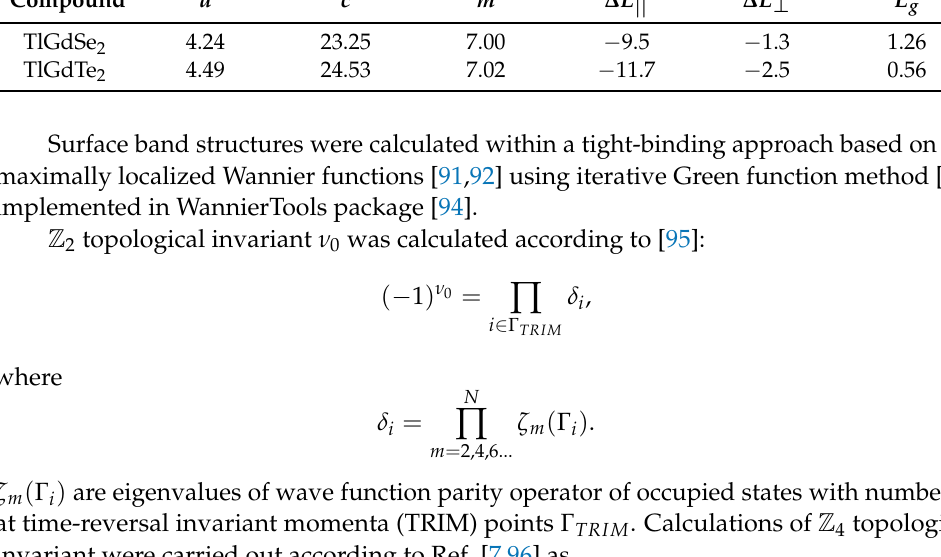
Table 1. Optimized hexagonal lattice constants, a and c (Å), local magnetic moment on the Gd atom, m ( µ ) , total energy differences of the AFM and FM configurations inside the Gd layer ( ∆ E B ( E + E ) /2, meV/[Gd pair]) and between the neighboring layers ( ∆ E ⊥ = E FM AFM pair]), and the bulk band gap E g (eV).